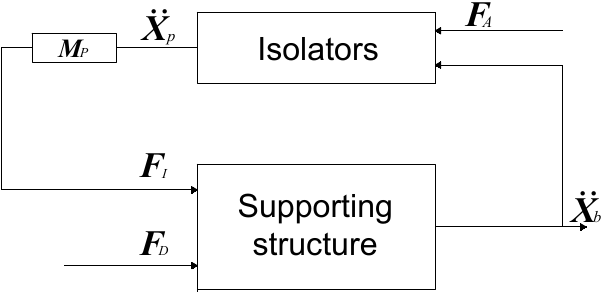
Figure 2. Schematic block diagram of the coupled isolator–structure